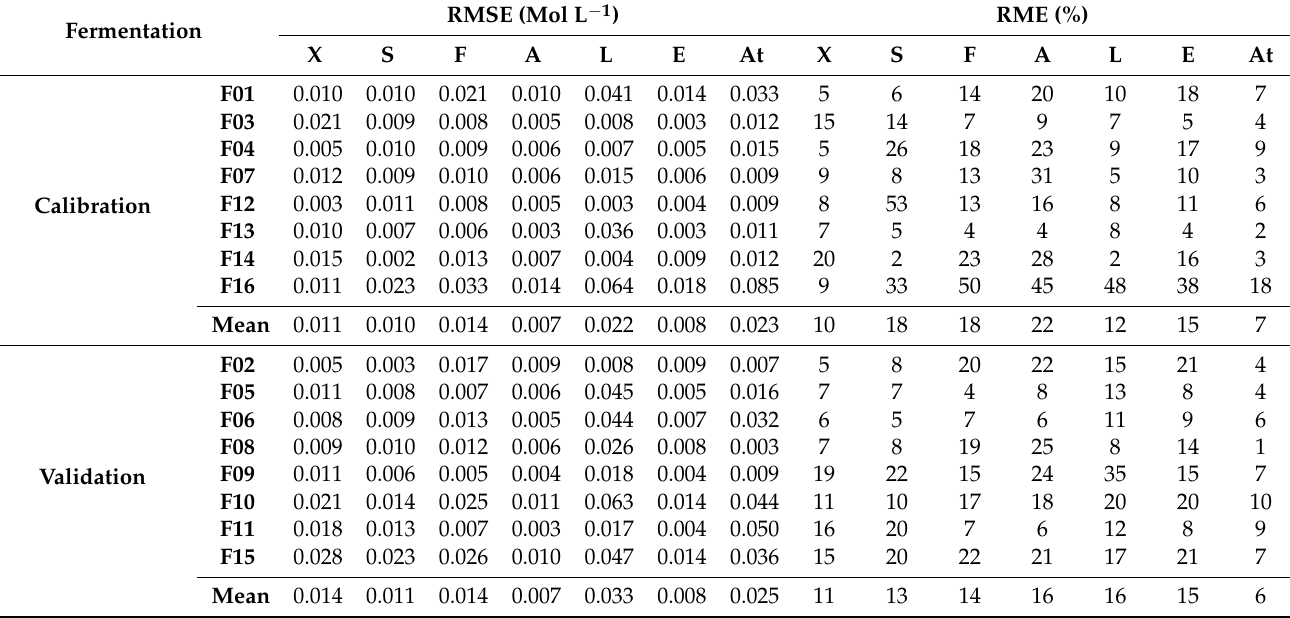
Table A3. Quality of fit of the model with parameters computed with the response surface